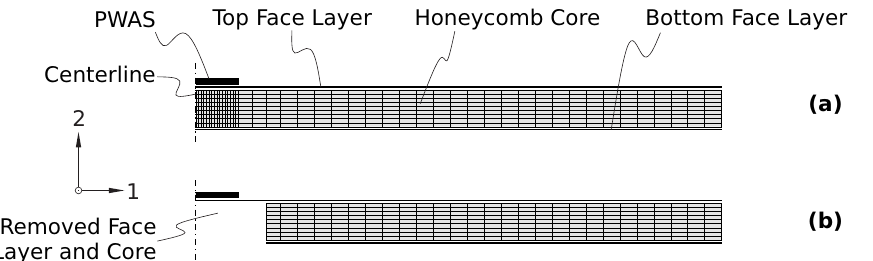
Figure 2. Axisymmetric FE model of sandwich panel in ( a ) pristine condition, and ( b ) with face layer debonding of a radius of 8.33mm (non-scaled